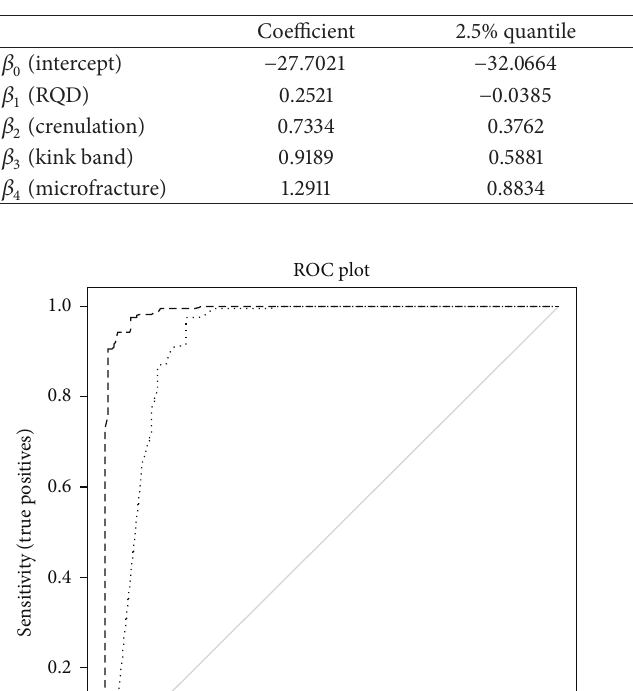
Table 3: Estimated coefficients and 2.5%, 25%, 75%, and 97.5% quantiles for the GLSM.